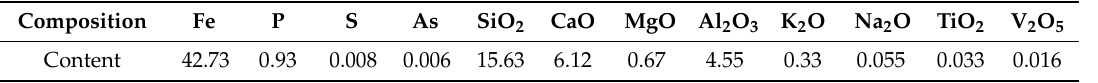
Table 1. Chemical composition of oolitic iron ore sample (%).